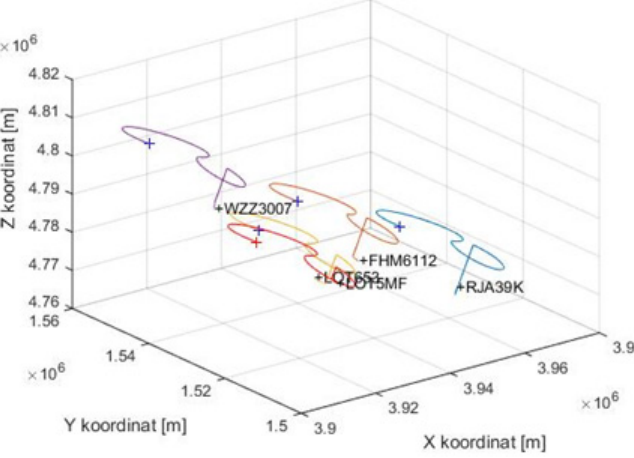
Figure 4. FOs’ flight trajectories for maneuverer flight.